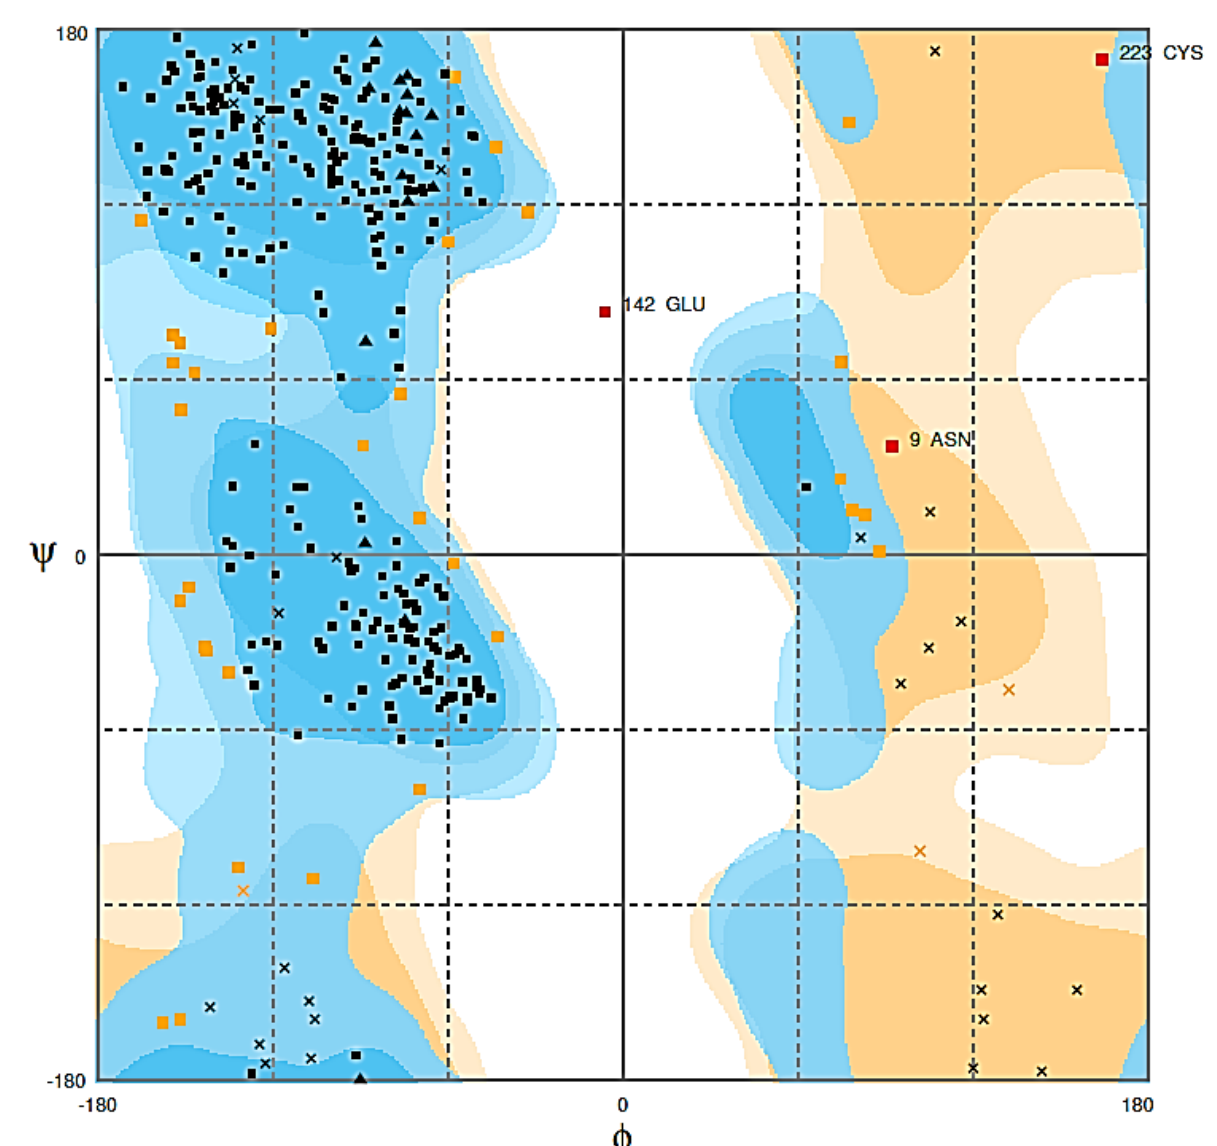
FIGURE 3 - Ramachandran plot of predicted